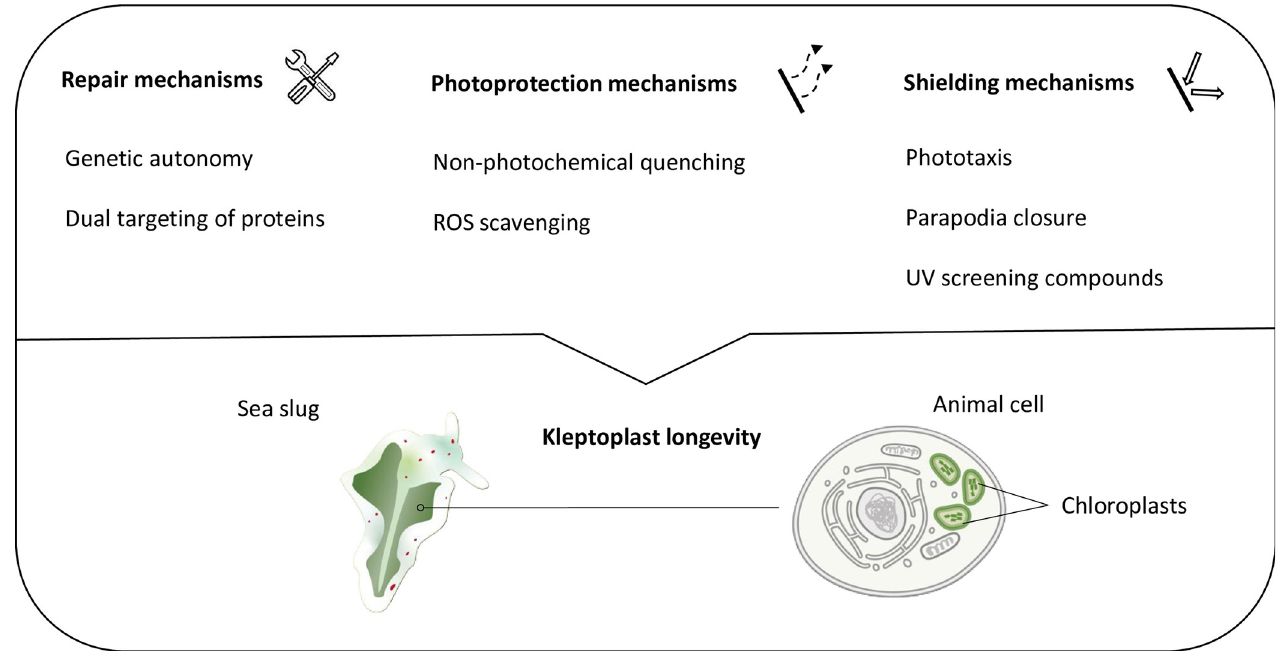
Fig 3. Repair and avoidance mechanisms involved in kleptoplast longevity. Schematic representation of repair, photoprotection, and shielding mechanisms putatively involved in the long-term maintenance of photosynthetic active chloroplasts in sacoglossan sea slugs.